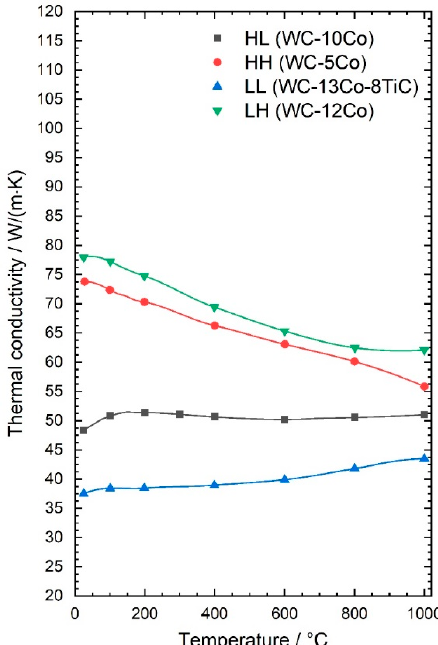
Figure 3. Thermal conductivity of the studied cemented carbides as a function of temperature.